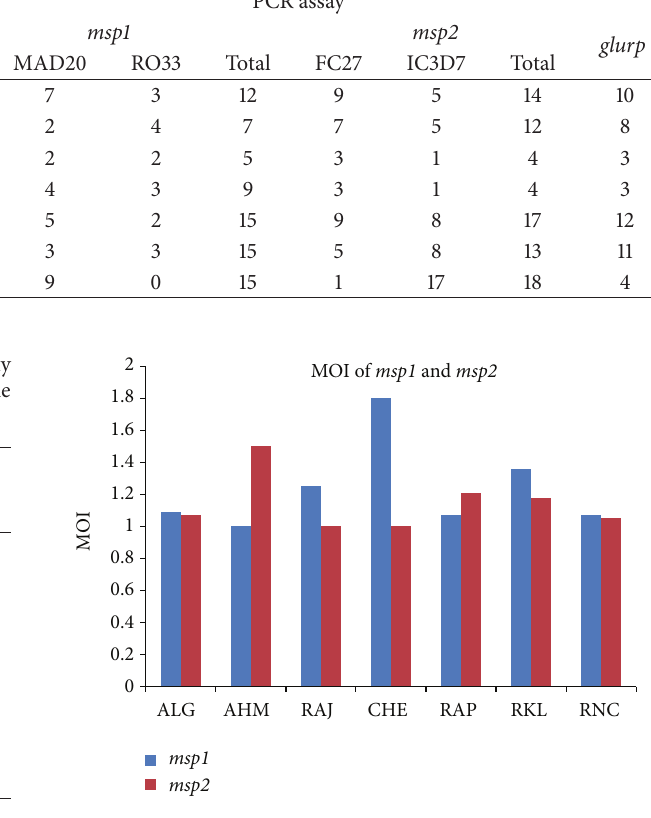
Figure 4: Graph showing comparison of MOI for msp1 and msp2 genes in different regions of India. ALG: Aligarh, AHM: Ahmedabad, RAJ: Rajasthan, CHE: Chennai, RAP: Raipur, RKL: Rourkela, and RNC: